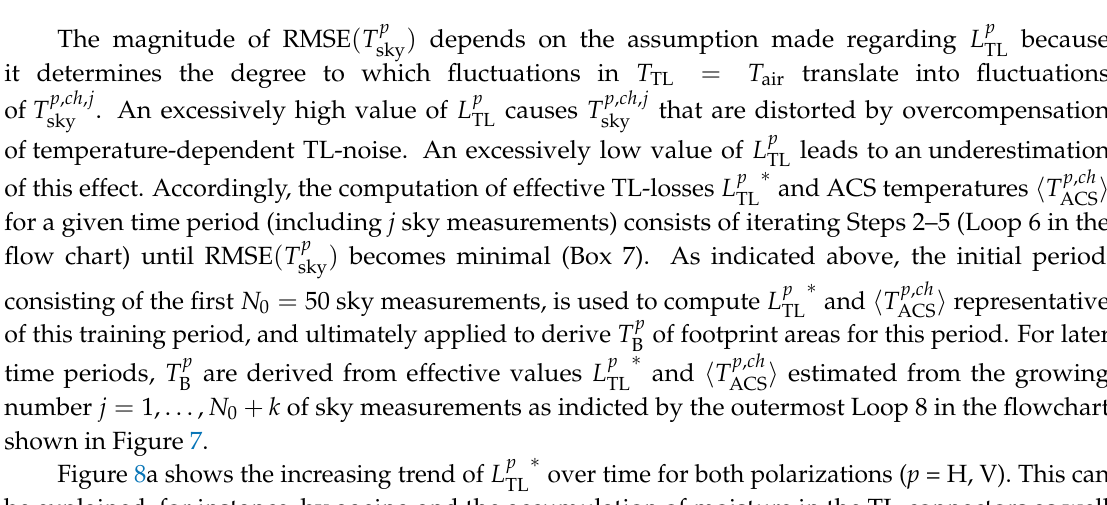
Figure 7. Flowchart illustrating the course of action followed to estimate effective losses of transmission line (TL) and active cold source (ACS) noise temperatures.